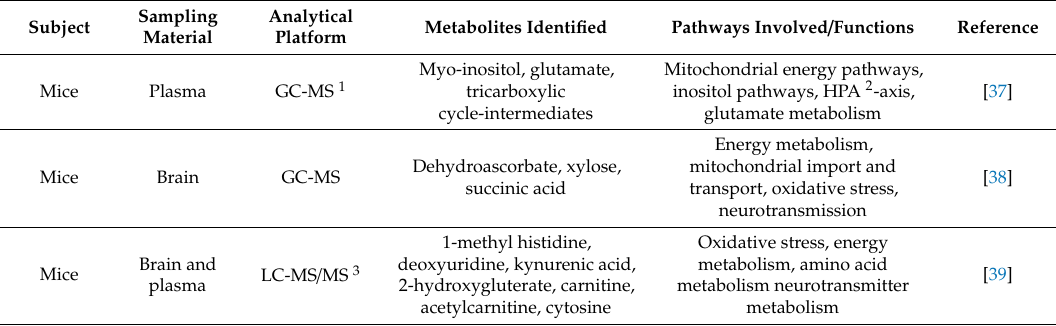
Table 1. Possible biomarkers identified to di ff erentiate healthy and anxiety